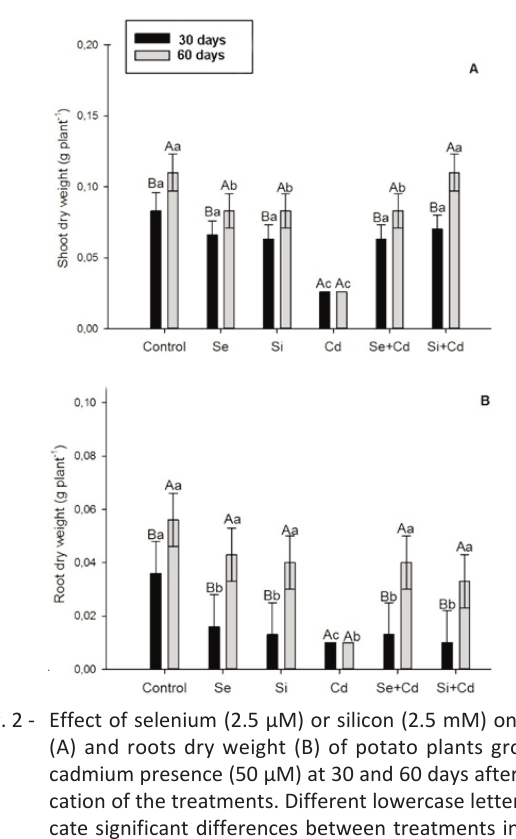
treatment.Fig. 2 - Effect of selenium (2.5 μM) or silicon (2.5 mM) on shoot